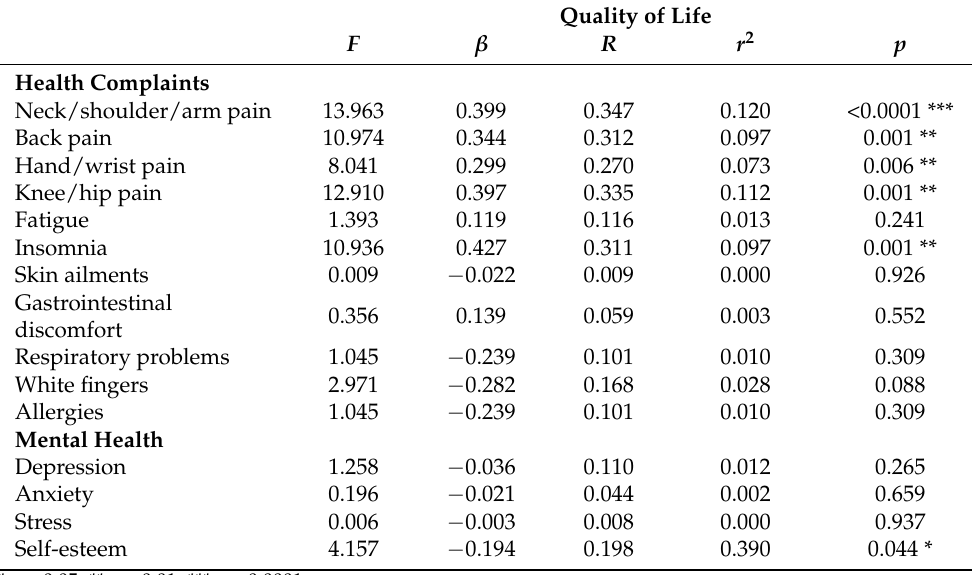
Table 5. Relationship between health complaints, mental health and QoL